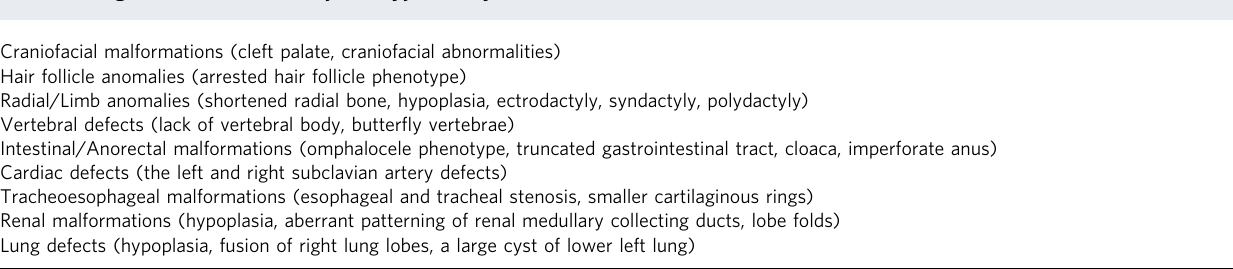
Table 1 Congenital malformation phenotypes in Dyrk2 − / − mice. Craniofacial malformations (cleft palate, craniofacial abnormalities) Hair follicle anomalies (arrested hair follicle phenotype) Radial/Limb anomalies (shortened radial bone, hypoplasia, ectrodactyly, syndactyly, polydactyly) Vertebral defects (lack of vertebral body, butter fl y vertebrae) Intestinal/Anorectal malformations (omphalocele phenotype, truncated gastrointestinal tract, cloaca, imperforate anus) Cardiac defects (the left and right subclavian artery defects) Tracheoesophageal malformations (esophageal and tracheal stenosis, smaller cartilaginous rings) Renal malformations (hypoplasia, aberrant patterning of renal medullary collecting ducts, lobe folds) Lung defects (hypoplasia, fusion of right lung lobes, a large cyst of lower left lung)